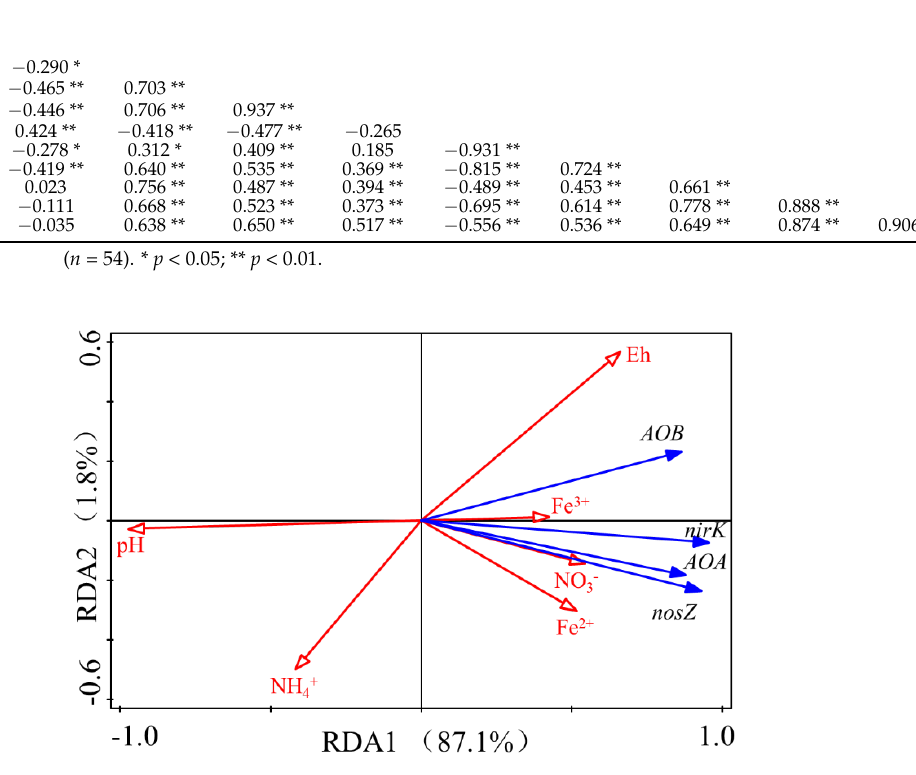
Figure 7. Redundancy analysis (RDA) result for AOA, AOB, nirK and nosZ gene abundance, and other properties in the two paddy soils. Table 4. Redundancy analysis (RDA) through Monte Carlo permutation test for the effects of soil Table 3. Correlation between N 2 O and measured environmental factors in the two paddy soils. properties on AOA, AOB, and nirK and nosZ gene